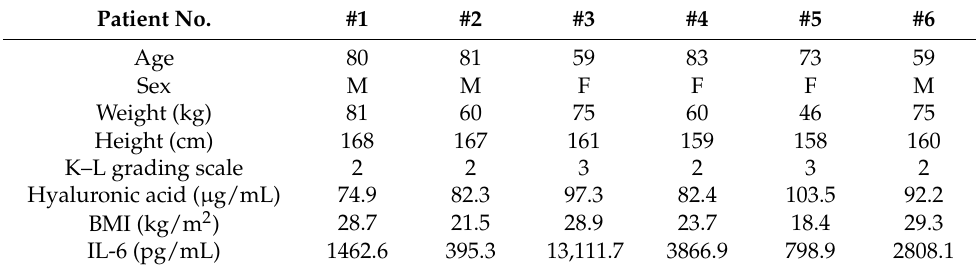
Table 1. Characteristics of patients who donated SF and the properties of SF. Patient No.